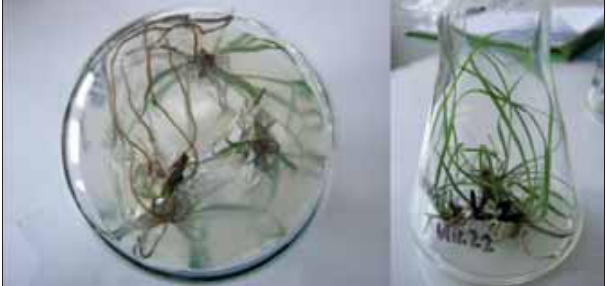
Figure 2. In vitro Nidularium ’Kertész Jubileum’ plants (left in worm’s-eye view and right in profile)